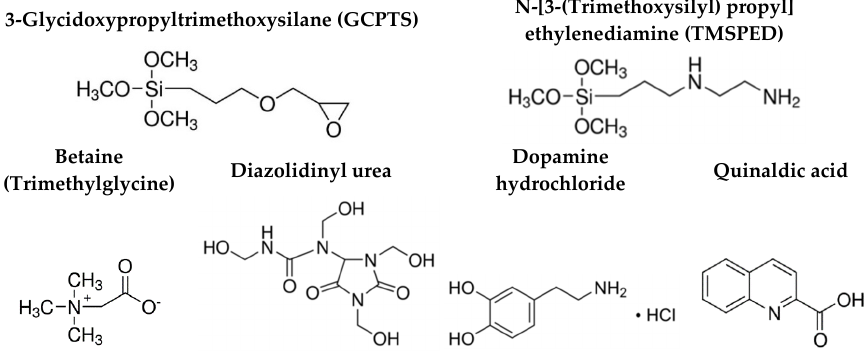
Figure 1. Precursor molecules; and, inhibitors for the sol ‐ gel formulation.